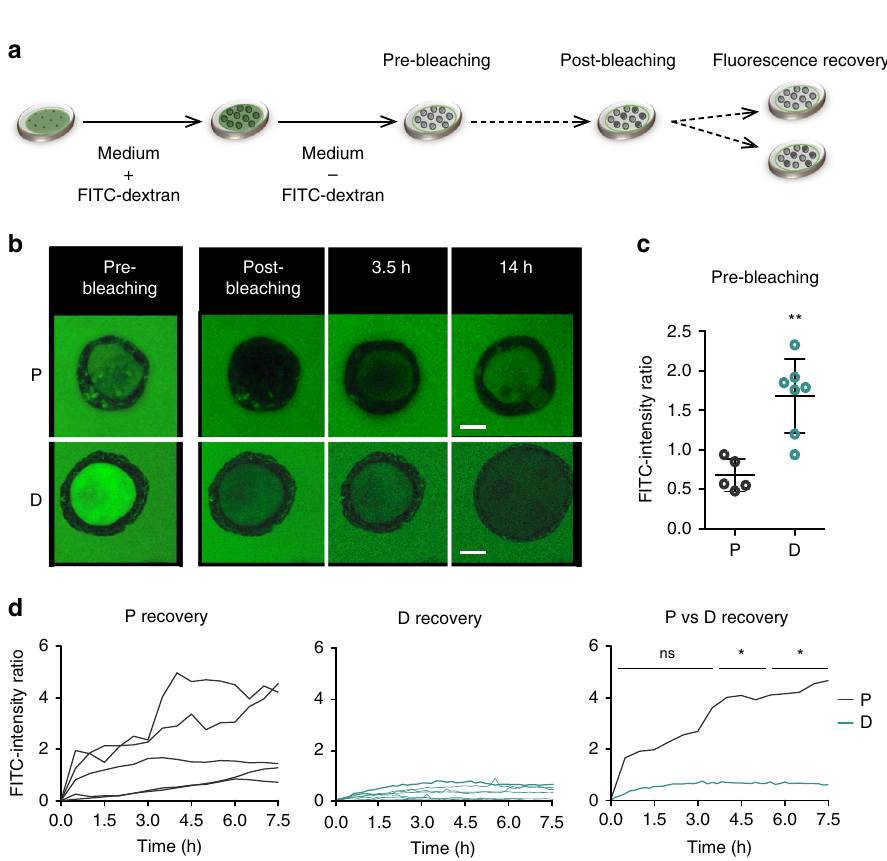
Fig. 3 Organoids cultured in differentiated conditions are functionally competent and acquire barrier function. a Experimental design to assess barrier function in organoid cultures using FITC-dextran and fl uorescence recovery after photobleaching (FRAP). b Example of P and D organoids during the FRAP assay (pre-bleaching, post-bleaching and recovery — 3.5 and 14 h) (scale bar, 1000 μ m). c Quanti fi cation of FITC-dextran intensity of P ( n = 5) and D ( n = 7) organoids in the pre-bleaching phase showing speci fi c FITC-dextran retention in differentiated organoids (Mann – Whitney test, error bars indicate SD). d Fluorescence recovery in P ( n = 5) (left) and D ( n = 7) organoids (middle); mean fl uorescence recovery in P vs D organoids (Mann – Whitney test, error bars indicate SD). * p ≤ 0.05, ** p ≤ 0.01. Source data are provided as a Source Data fi urothelial markers (i.e. Krt14 , Krt5 , Cd44 , Cd49f , and Trp63 ) and (Supplementary Fig. 4e, f). Apical expression of ZO-1 and the upregulation of suprabasal markers (i.e. Krt19 , Krt8 , Foxa1, CLDN4 was con fi rmed in differentiated organoids (Fig. 6c). The Ppar γ , Upk1a , Upk1b , Upk2 , and Upk3a ) in D conditions (Fig. 6a, predicted expression pattern of CLDN1, CLDN3, and CLDN4 Supplementary Fig. 4c), as well as the robust regulation of addi- was validated using information from the Human Protein Atlas tional keratin species (Supplementary Fig. 4d). (https://www.proteinatlas.org/). Epithelial impermeability and Manual curation also revealed dynamic changes in expression endocytic traf fi c were signi fi cantly up-regulated in D organoids, of cell – cell adhesion genes. Transcripts coding for tight junction in agreement with results of the FITC-dextran assays components showed two distinct expression patterns: Cldn1 , described above. Cldn8 , Cldn12 , and Cldn25 were down-regulated upon differ- Gene set enrichment analysis (GSEA) revealed a highly entiation whereas Cldn3 , Cldn4 , Cldn7 , Cldn23 , Ocln, Zo-1, Zo-2 , signi fi cant downregulation of the activity of pathways involved and Zo-3 were up-regulated (Fig. 6b), suggesting distinct in cell cycle, DNA repair, RNA biology, protein synthesis, and functions and cellular distribution for the corresponding proteins. cytokines in D organoids; this was accompanied by increased activity of pathways involved in epithelial differentiation/cell – cell adhesion, intracellular traf fi c (endocytosis, lysosome), and